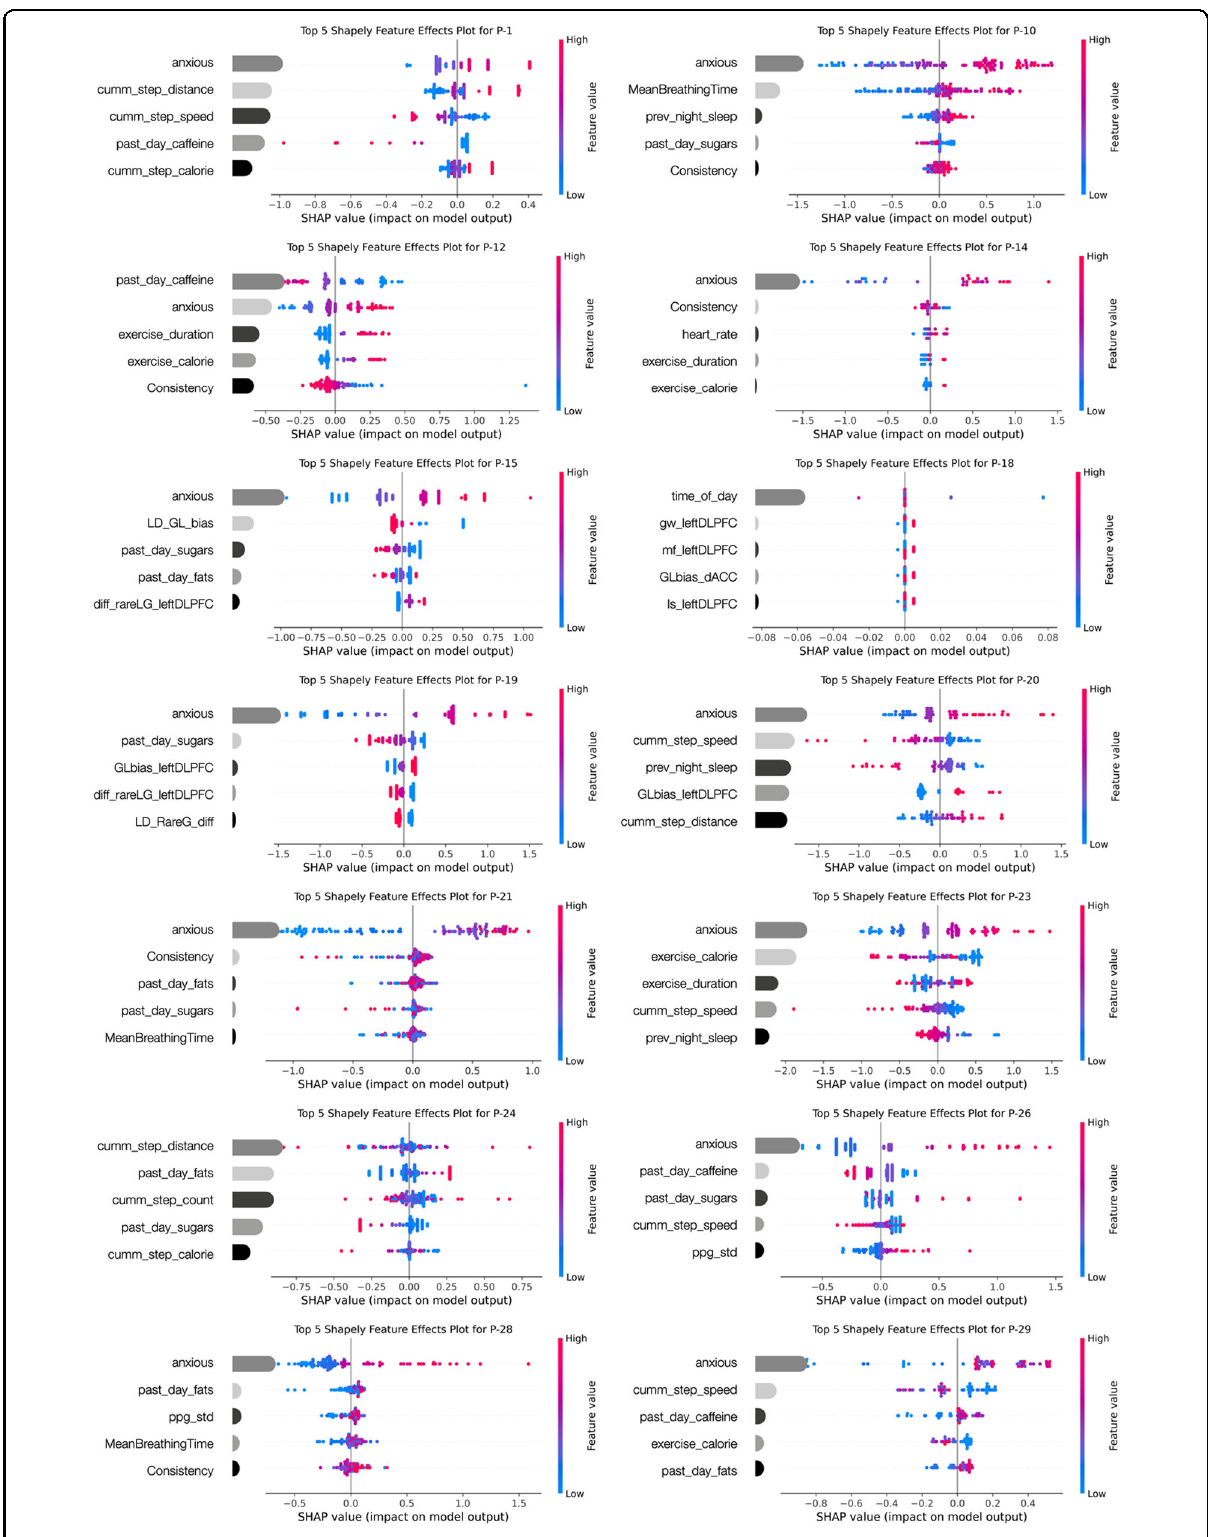
Fig. 4 (See legend on next